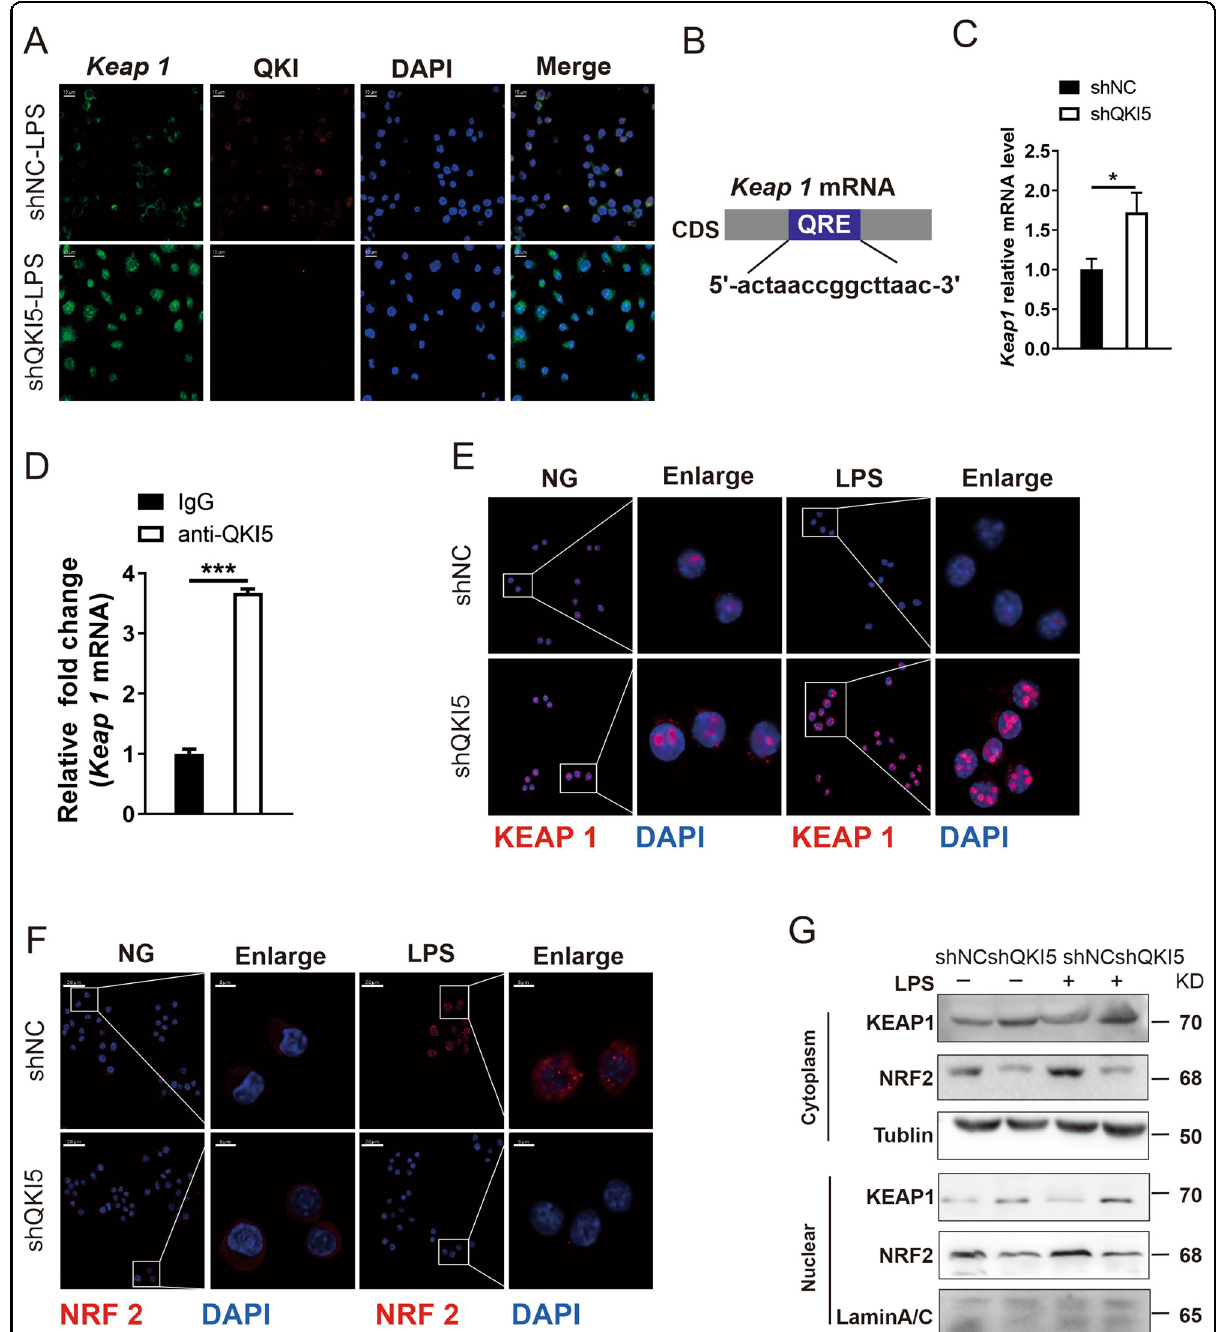
Fig. 4 QKI directly affected Keap1 mRNA localization and protein expression. A RNA FISH was carried out to detect the interaction between QKI protein and Keap1 mRNA. ShNC and shQKI5 cells were stimulated with LPS (100ng/mL) for 24h and then hybridized both with Keap1 mRNA interaction probes (green) and QKI antibody (red). Nuclei are stained with DAPI (blue). Scale bar: 10 μ m. B Bioinformatics analysis of the QKI binding site in the 3 ′ UTR-to-CDS of Keap1 mRNA. Regions corresponding to a potential QKI response element (QRE) sequence are shown in shaded boxes. C q-PCR detected the mRNA expression level of Keap1 mRNA in shNC and shQKI5 cells. D RNA immunoprecipitation analysis using QKI antibody followed by real-time PCR to measure the mRNA levels of Keap1 in QKI overexpressed RAW 264.7 cells (LV-QKI5, and LV-Cherry was a control) treated by LPS for 24h, with β -actin used as a normalization control. E , F Confocal images of shNC and shQKI5 cells that were stimulated with LPS for 24 h and labeled with Abs against the appropriate protein. NRF2 and KEAP1 staining are shown in red and DAPI shown in blue. Scale bar, 20µm and 5 μ m (enlarge). G Western blotting analysis the expression of KEAP1 and NRF2 in lysates of cytoplasm and nuclear protein. All bars represent the mean of measurements from three independent experiments, and the error bars indicate ±SEM; * P < 0.05, ** P < 0.01, *** P <0.001, two-tailed Student ’ s t test ( C , D